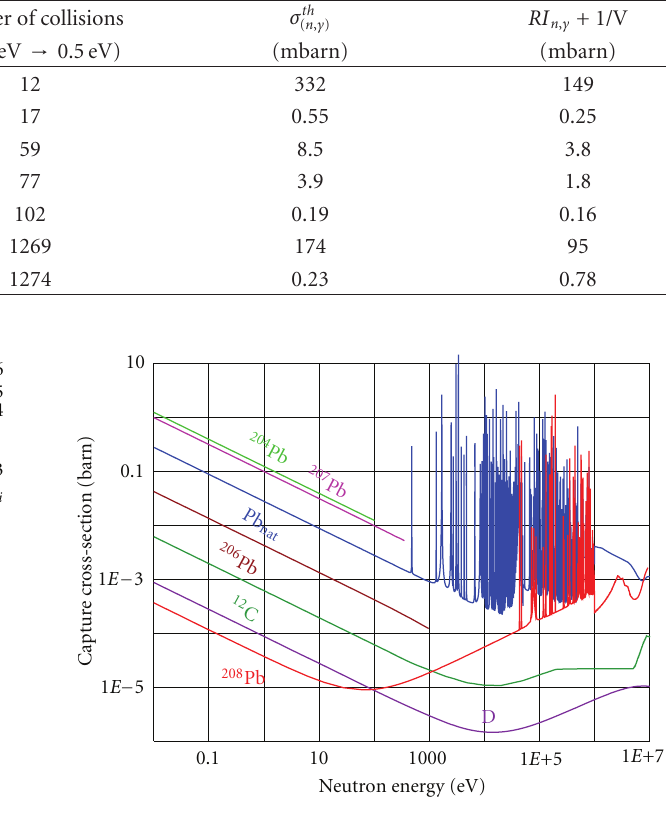
Figure 2: Capture cross-section of various nuclides as a function of neutron